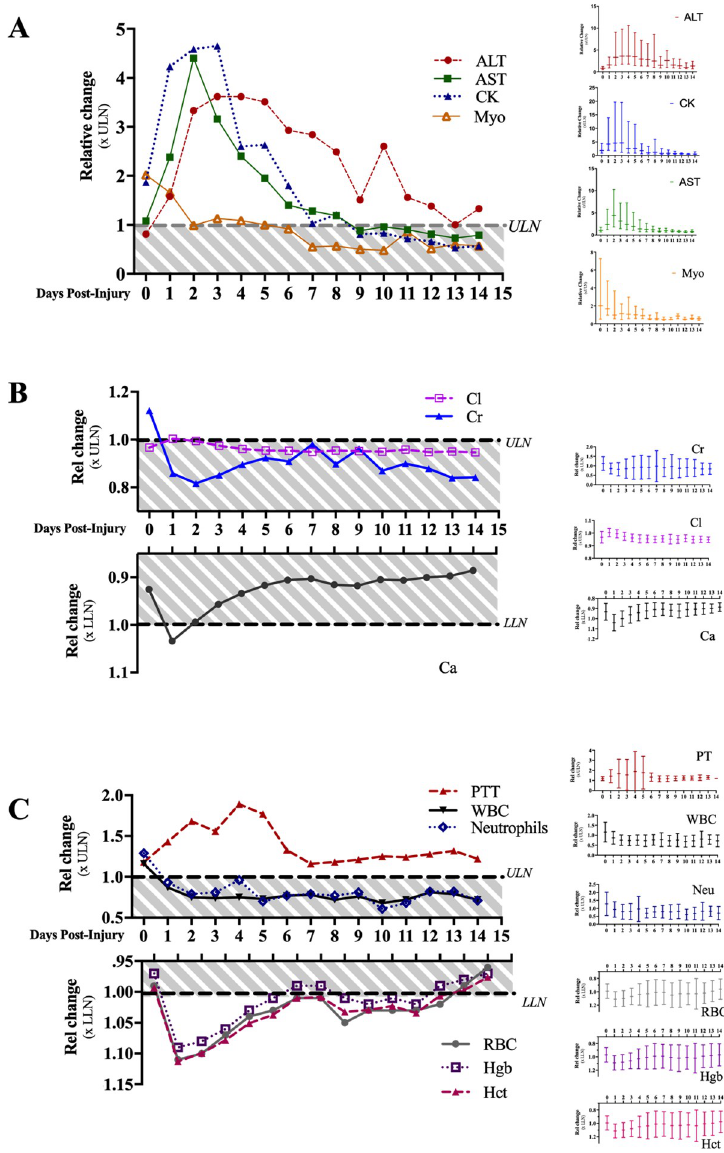
Fig 2. Profile of biomarker changes days following EHS. Biomarkers of multi-organ injury are represented as fold- change relative to limits of reference ranges; ULN = Upper Limit of Normal, LLN = Lower Limit of Normal. (A) Liver function and myolysis-associated enzymes shown as median values; in-set graphs show inner quartile range for each analyte. ( B ) Serum electrolytes, and ( C ) hematology and coagulation results shown as mean; in-set graphs show standard deviation for each analyte and day. Shaded values indicate values within reference